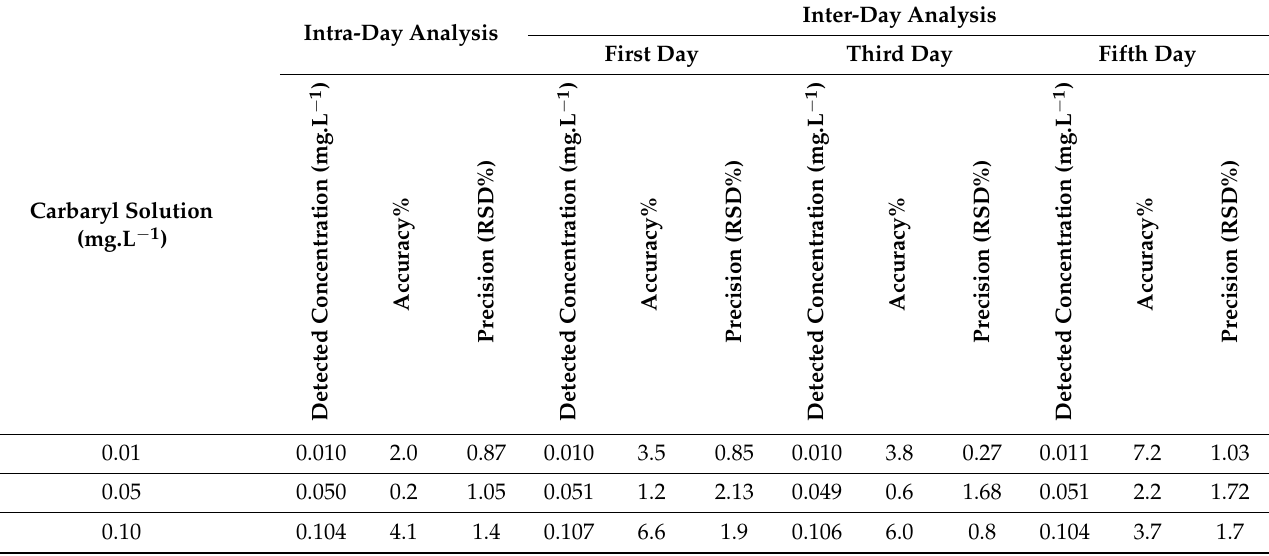
Table 3. Evaluation of the intra-day and inter-day precision for ( n = 7).